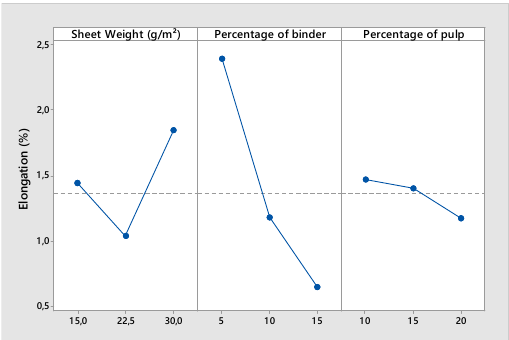
Figure 6. Main effects plot for elongation at break.